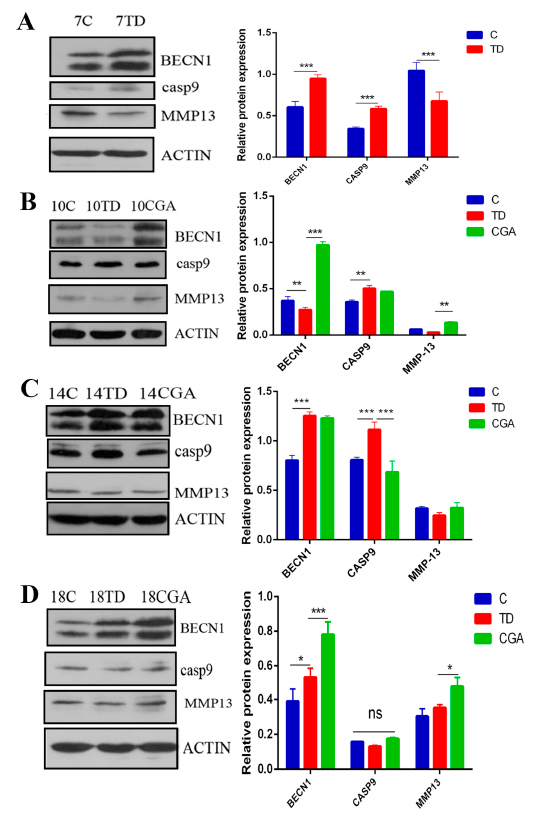
Figure 8. CGA regulates protein expression of BECN1, CASP9 and MMP13 in growth plate. ( A – D ) The relative protein expression of BECN1, CASP9, MMP13 in tibial growth plate were measured by western blotting at days 7, 10, 14 and 18. ACTIN was used as an internal control. All of the data represent means ± SD of three independent experiments. * p < 0.05, ** p < 0.01, *** p < 0.001.